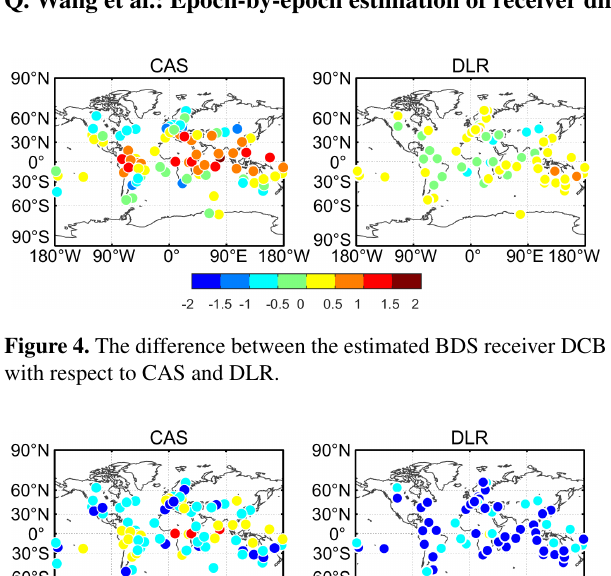
Figure 6. The intraday SD of receiver DCB for all stations on 4 consecutive days (2, 3, 4, and 5 January 2019).